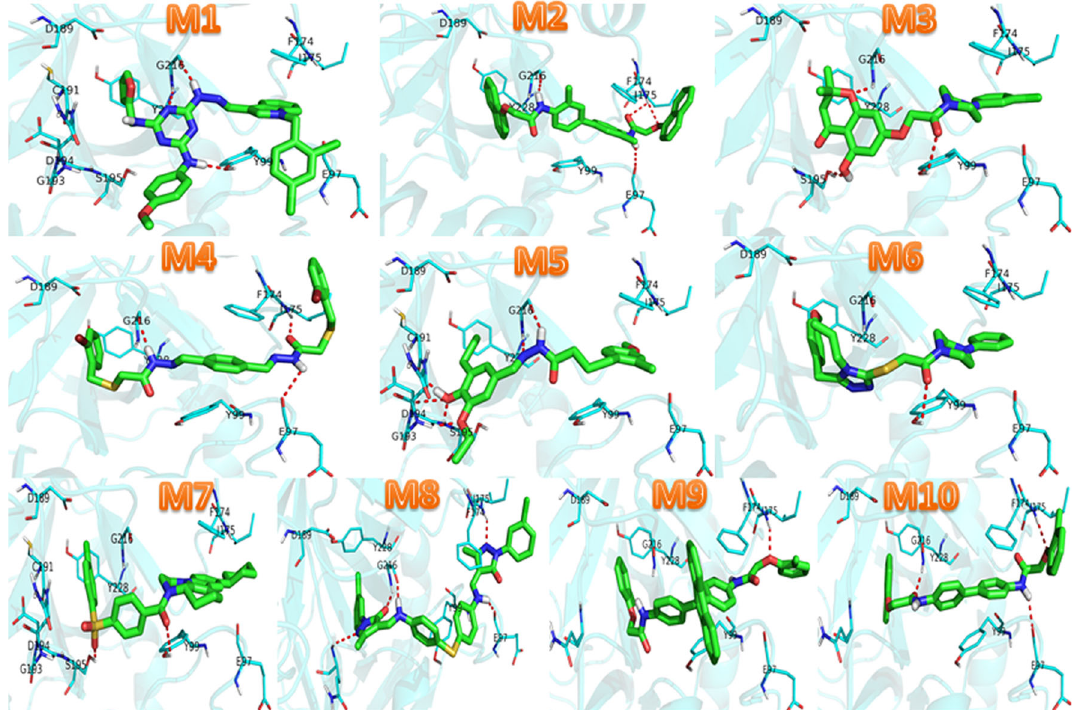
Fig. 6 The interactions between hits and FXa carried out by Pymol. Skyblue sticks were represented the residues in FXa, and the ligand was green , red dash line represented hydrogen